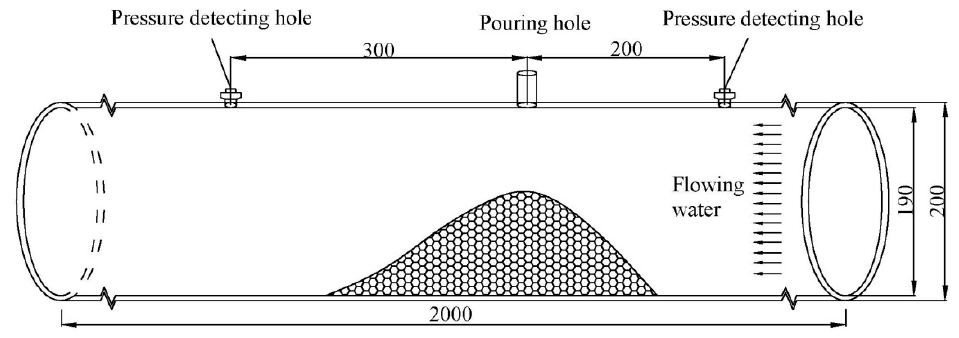
Figure 2. Schematic diagram of tunnel prototype with water flow (unit: mm).